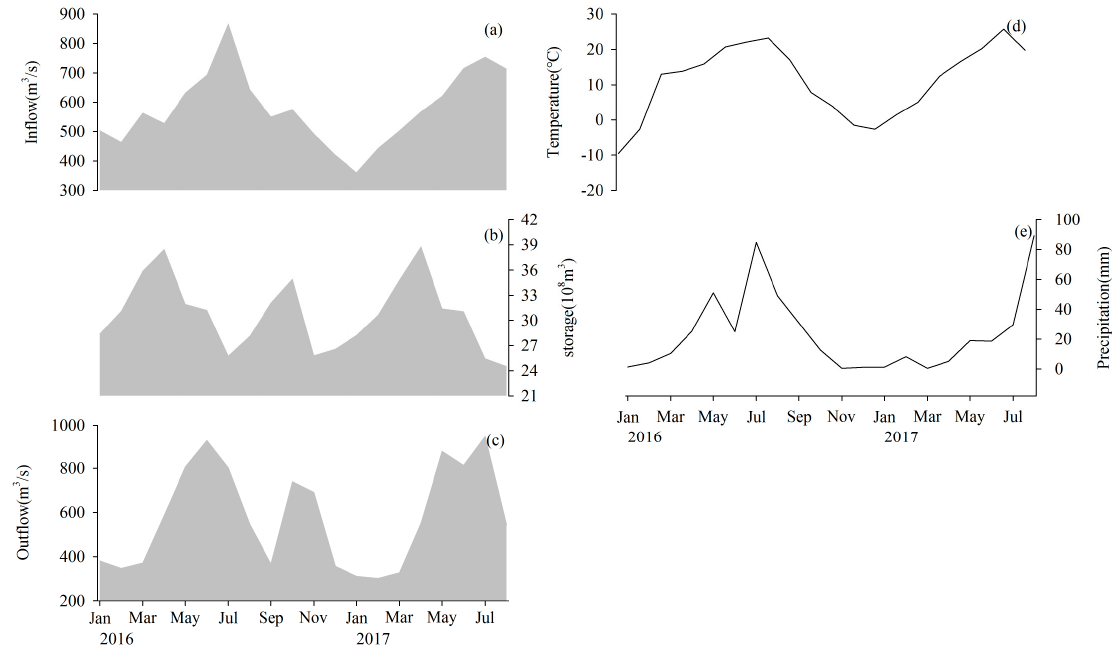
Figure 3. Seasonal variation of ( a ) inflow, ( b ) storage, ( c ) outflow, ( d ) air temperature, and ( e ) precipitation amount from January 2016 to August 2017.